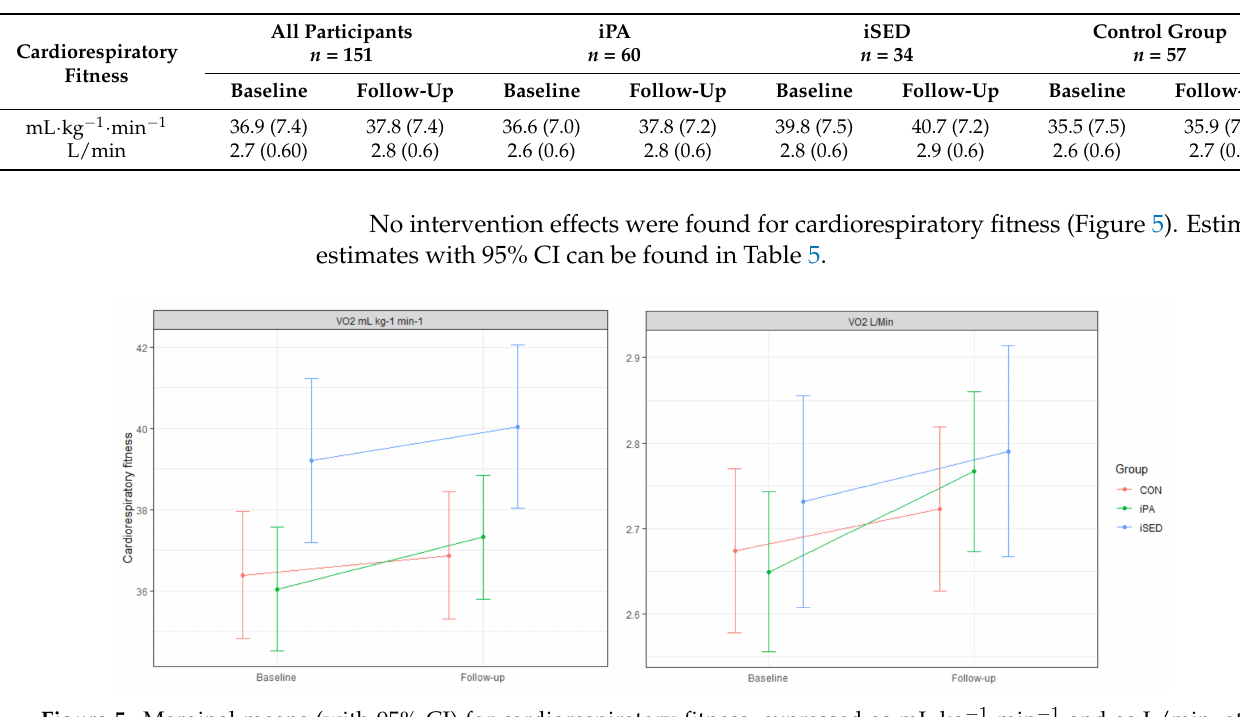
Figure 5. Marginal means (with 95% CI) for cardiorespiratory fitness, expressed as mL · kg − 1 · min − 1 and as L/min, at baseline and 6-month follow-up. Values were estimated based on the results in the linear mixed models. Table 5. Differences in change from baseline to follow-up between groups for cardiorespiratory fitness (estimates with 95% CI), based on the linear mixed models. Cardiorespiratory